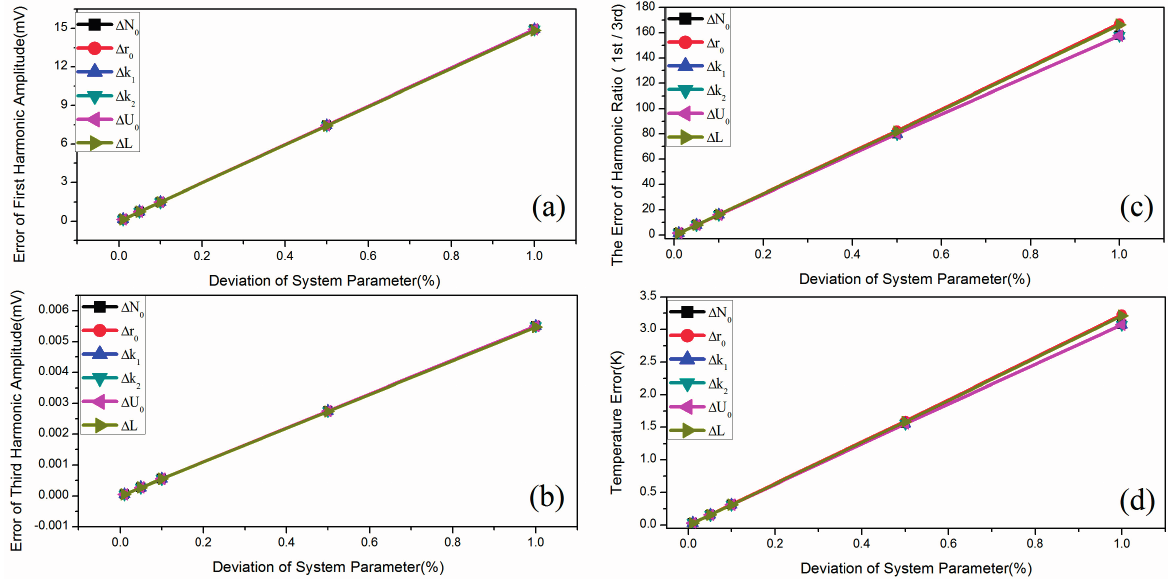
Figure 4. Harmonic measurement error resulting from the deviation of the parameters, such as the radius of the Helmholtz coils ( r 0 = 0.1025 m), the turn of the Helmholtz coils ( N 0 = 168), the AC impedance of the Helmholtz coils ( ω L = 44.06247 Ω ), the voltage gain of the power amplifier ( k 1 = 7.8), the attenuation coefficient of the power amplifier within the pass band ( k 2 = 1) and the signal source ( U 0 = 5.75 V). The deviation rates of these parameters are 0.01%, 0.05%, 0.1%, 0.5% and 1%, respectively. The MNPs follow a